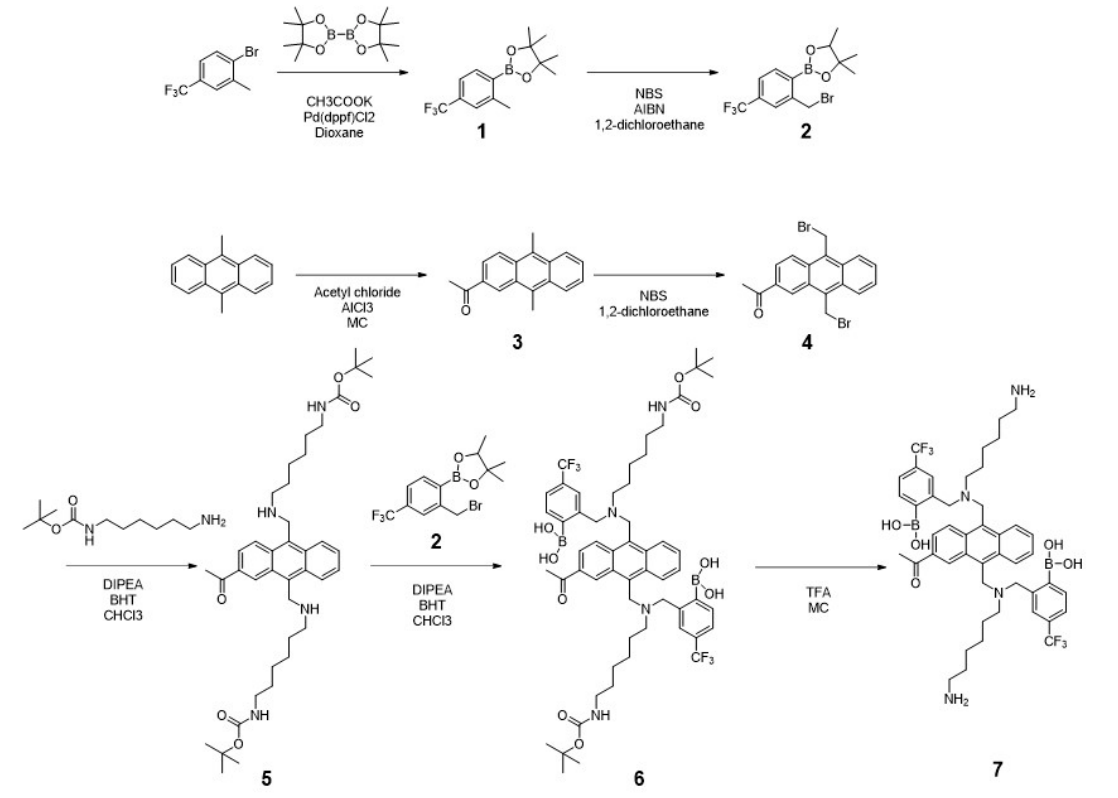
Scheme 1. Seven steps required for synthesizing diboronic anthracene with two primary amines for electrochemically detecting